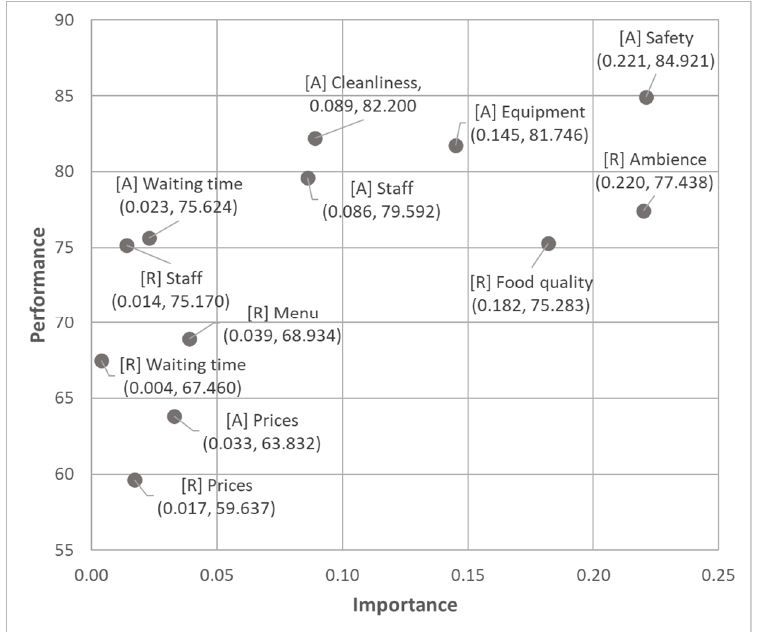
Figure 4. Importance–performance map analysis (IPMA) at indicator level. Note: Importance = unstandardized total effects; Performance = rescaled variables’ scores; [A] = Amusement services; [R] = Restaurant.